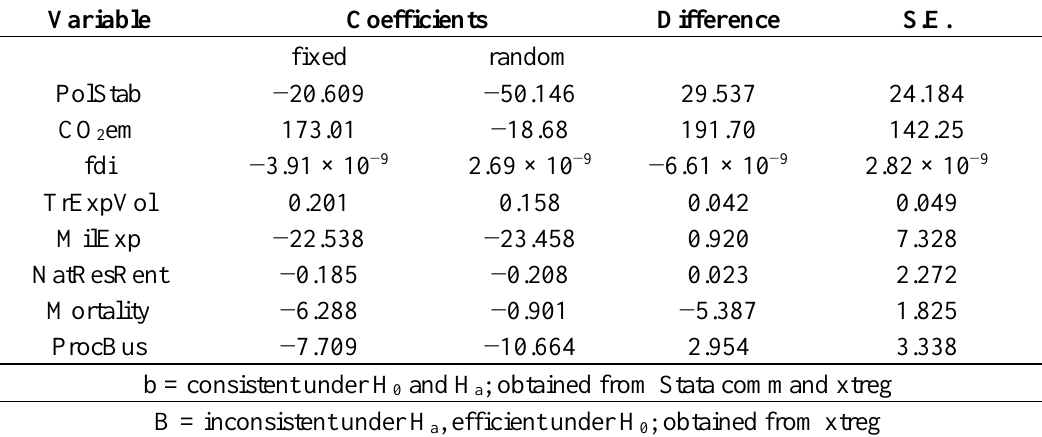
Table A1. Housman test supporting the preference for a fixed effects